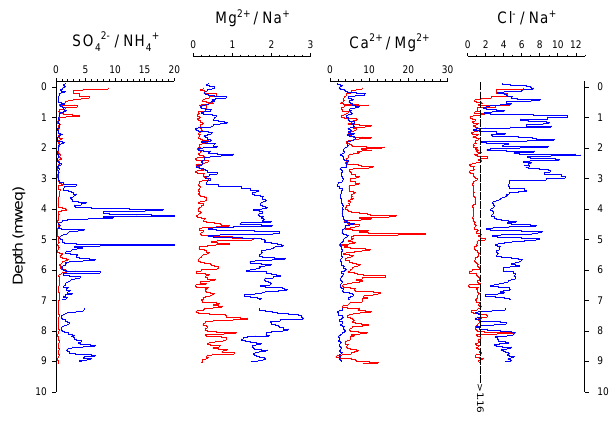
Figure 3 Fig. 3. the selected ionic ratios profiles for both Chimborazo ice cores (red line for core A, blue line for core B) illustrate the pref- erential elution and re-localization of some ionic species. For Cl − /Na + , the dashed line at 1.16 represent the sea salt ratio from (Keene et al.,